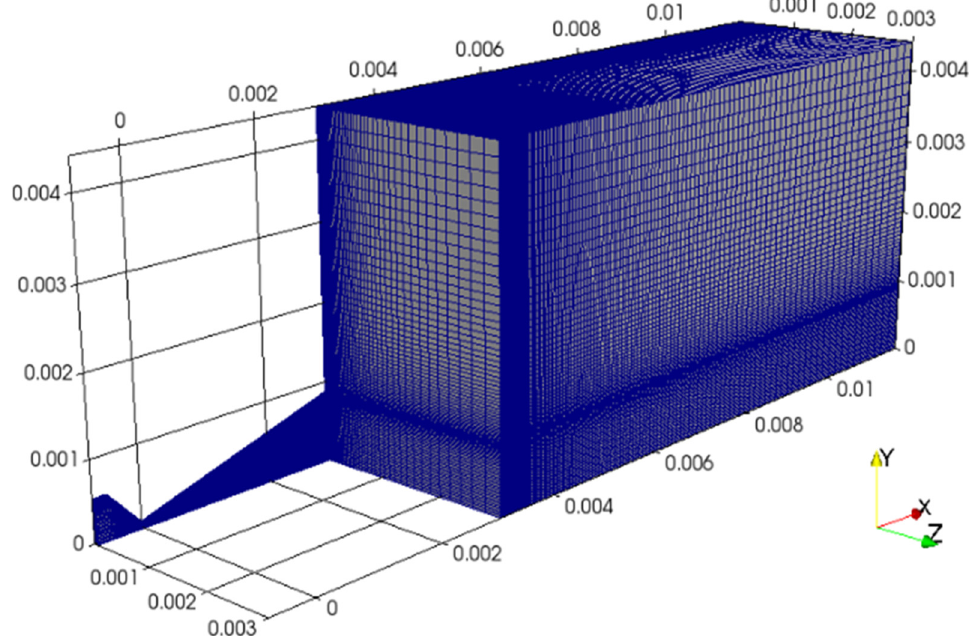
Figure 3. 3D computational domain [4]. Table 4. 3D grid independence study.